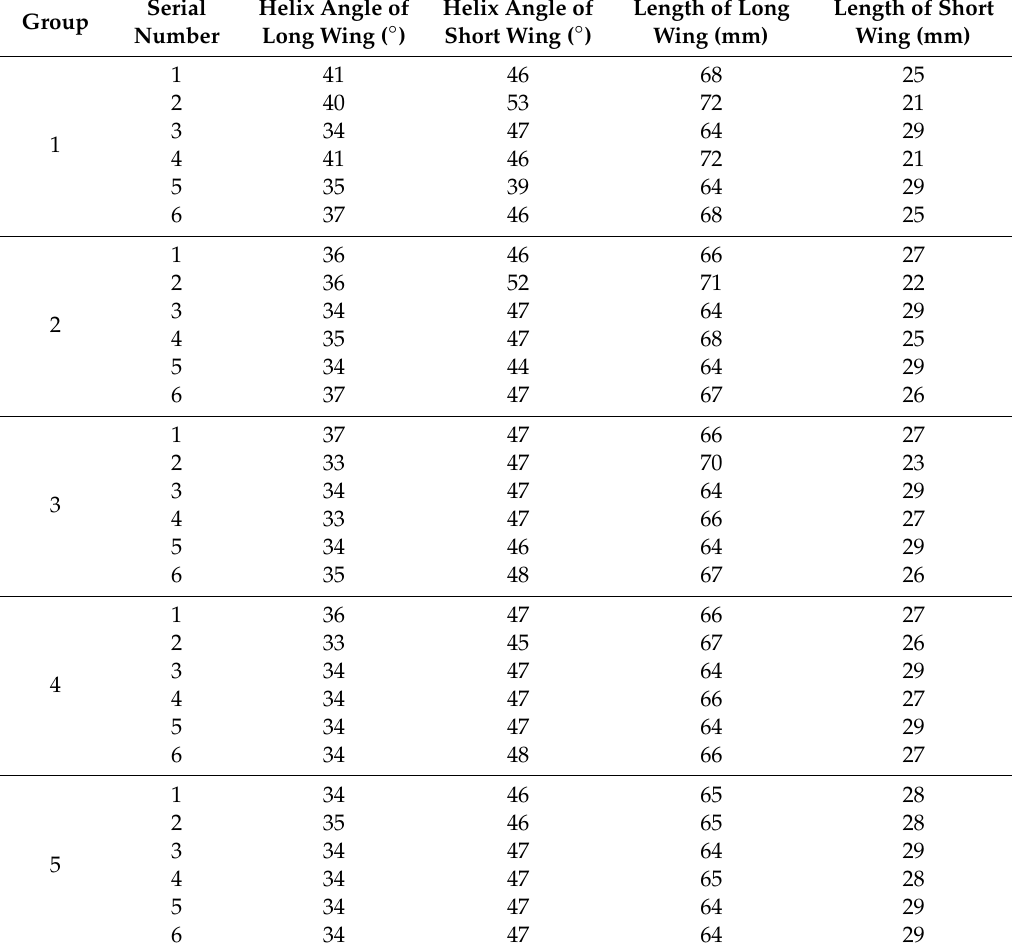
Table 2. Convex edge parameters for each generation of particles.